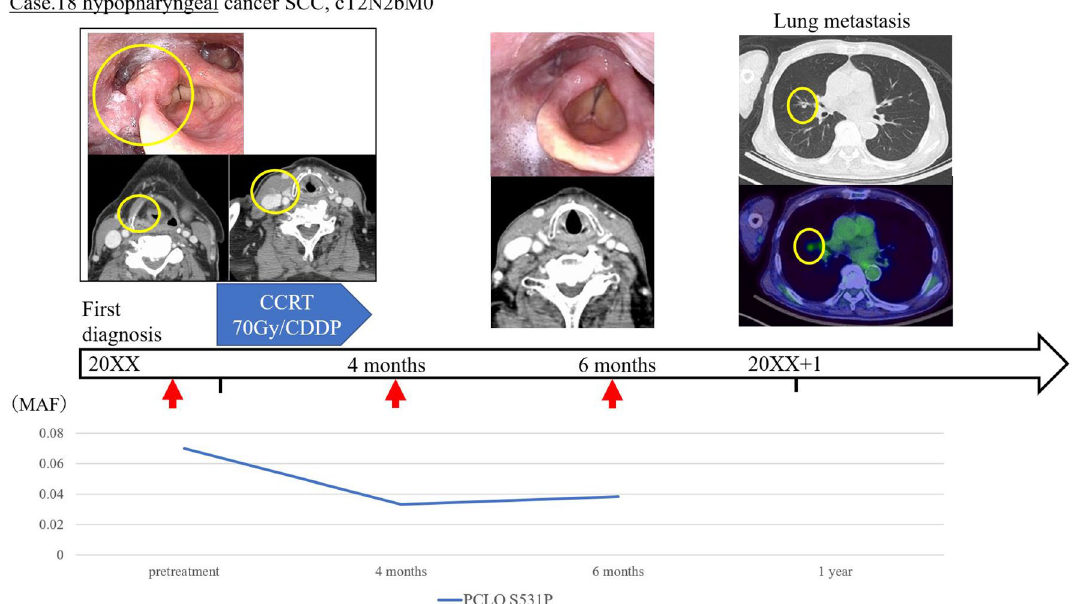
Figure 4. Sample case for use of plasma circulating tumor DNA to detect HNSCC (Case 18). Clinical course of patient #18. This patient exhibited a hypopharyngeal carcinoma cT2N2bM0 and was treated with chemoradiotherapy. Before treatment, ctDNA was detected via PCLO/S531P. Post-treatment imaging showed that the tumor and lymph metastasis had disappeared, but ctDNA was still detected 6 months after treatment. Lung metastasis was observed in the first year after